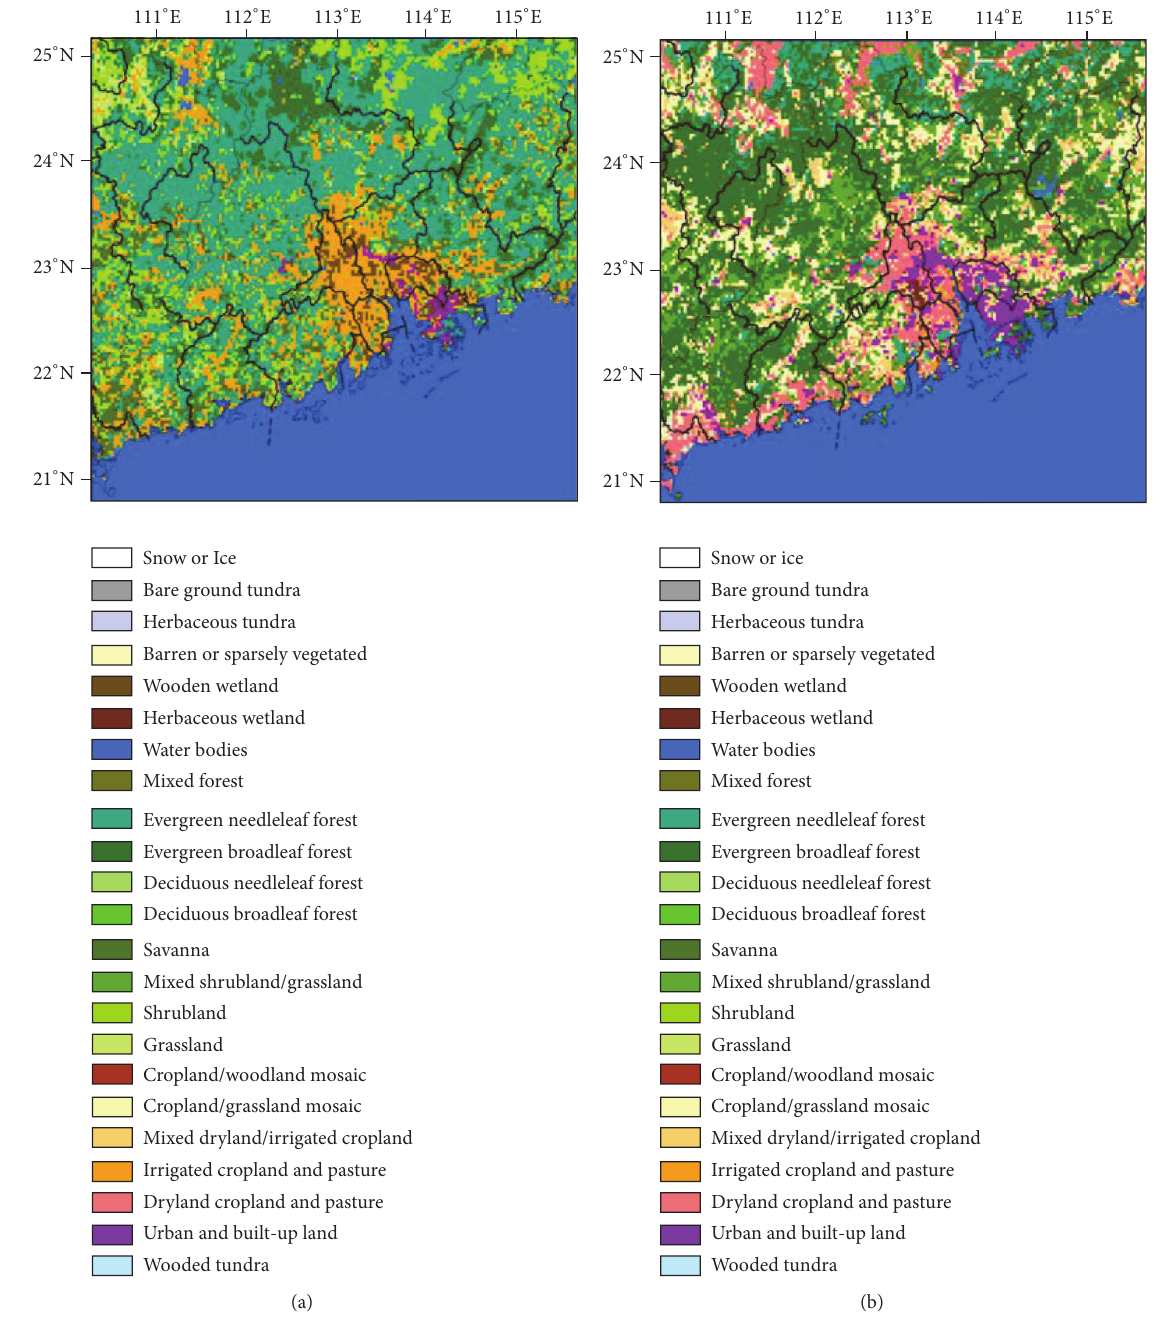
Figure 2: The landscape distributions of different land cover datasets in the PRD region: (a) the GLC2000 dataset; (b) the GLC2009 dataset.